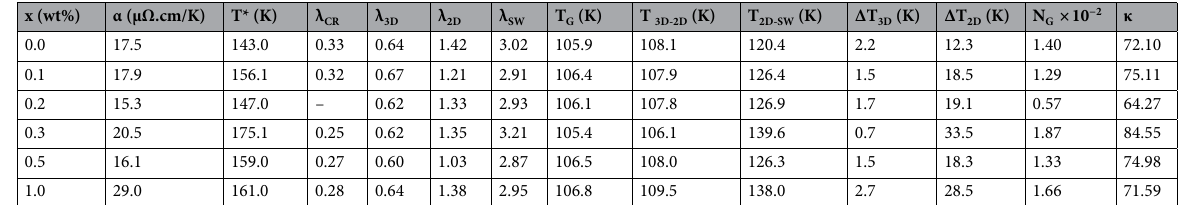
Table 1. Conductivity exponents, crossover `oscopic parameters estimated from electrical resistivity measurements and fluctuation induced conductivity